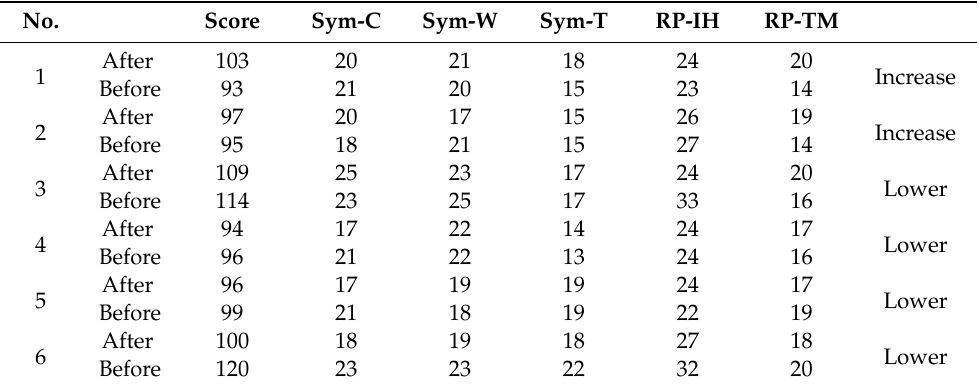
Table 12. Pre- and post-test on distribution of change in high-risk Internet